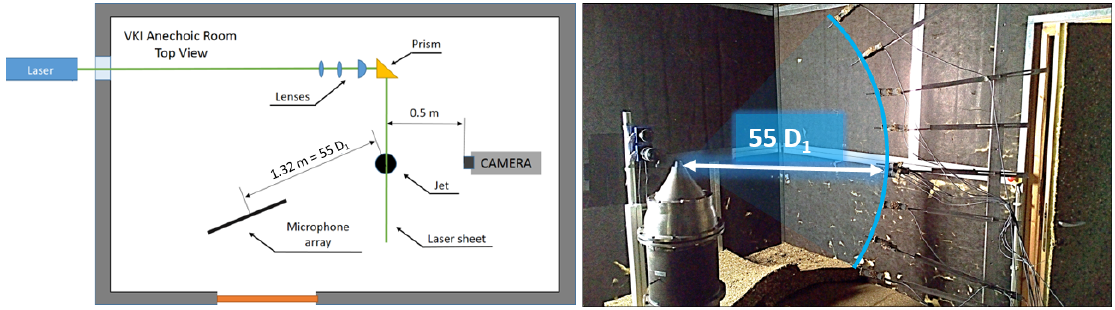
Figure 15. Sketch and picture of the experimental setup. The laser equipment, source of unwanted noise is located outside the anechoic room. Two spherical lenses and one cylindrical lens have been used to create the laser